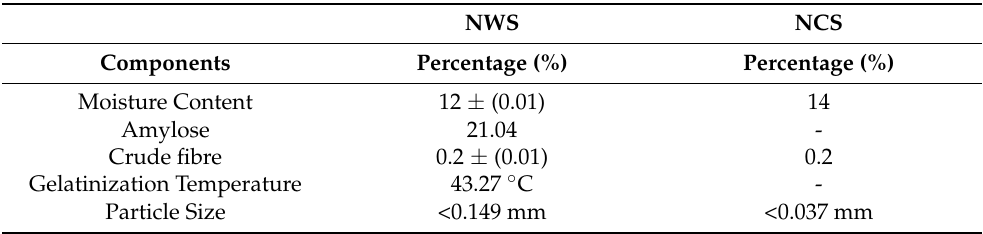
Table 1. Composition of the native cassava starch (NCS) and native cassava starch extracted using the wet